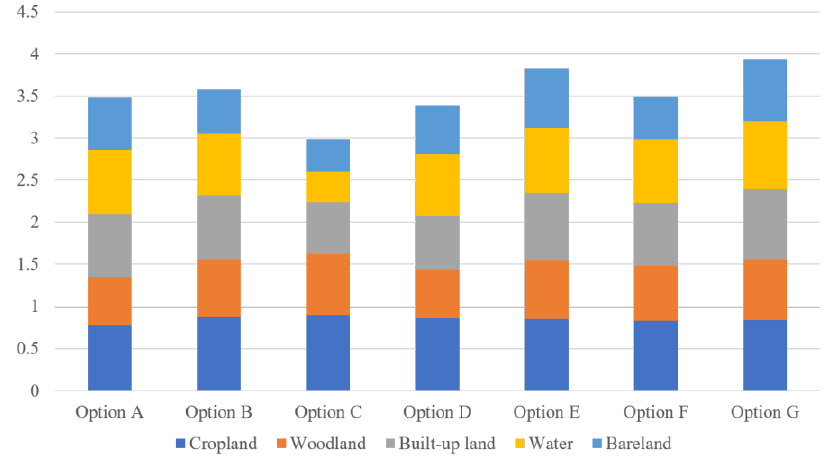
Figure 5. F1 scores for 2013.